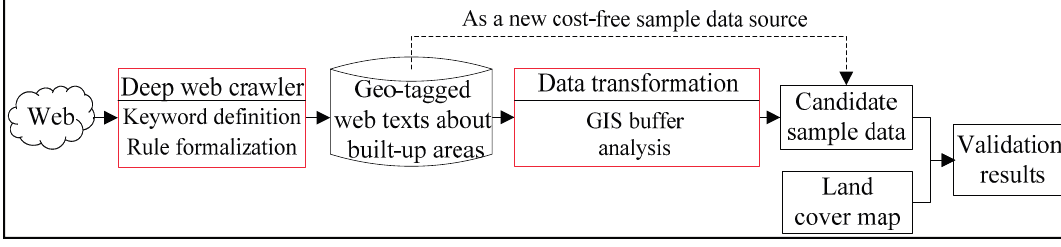
Figure 2. The conceptual framework of active sample data